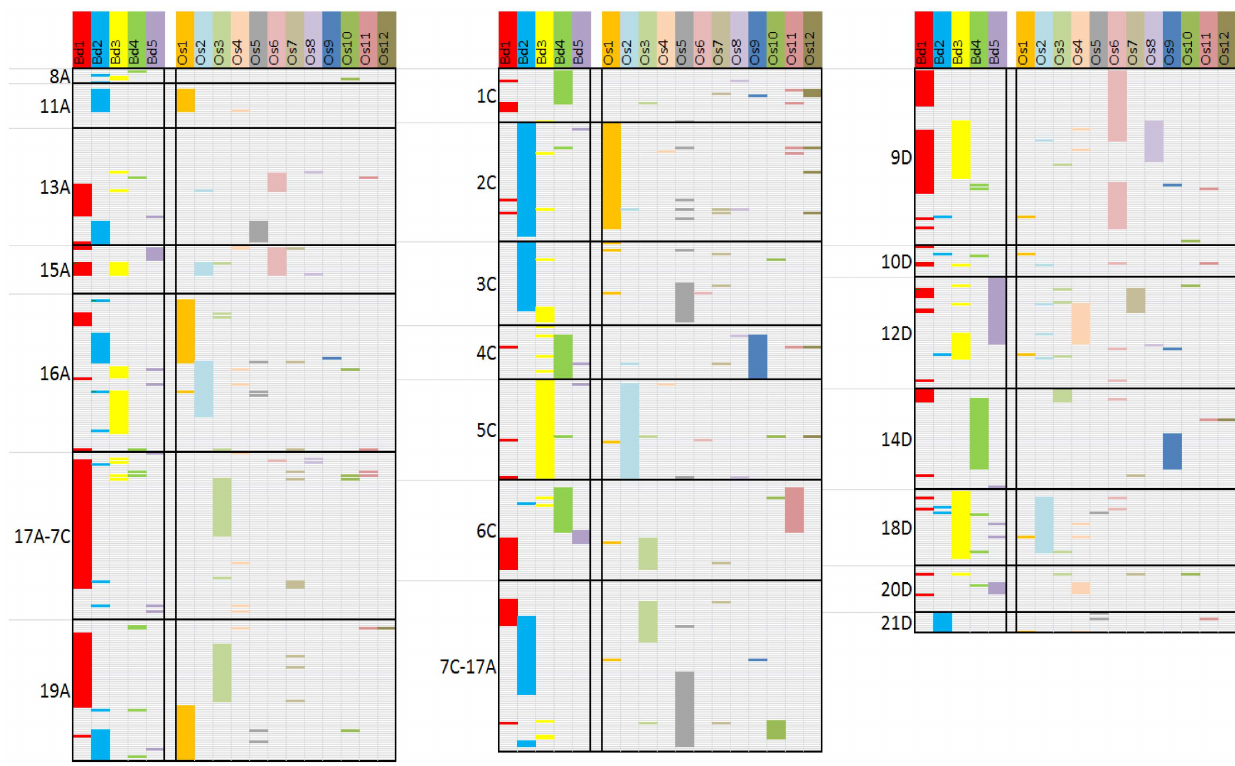
Figure 4. Regions of sequence similarity between SNP markers on 21 chromosomes from an oat consensus map (8A to 21D) and chromosomes from the sequenced genomes of Brachypodiumdistachyon (Bd) and Oryzasativa (Os). Regions of substantial colinearity have been interpolated using chromosome-specific colors.